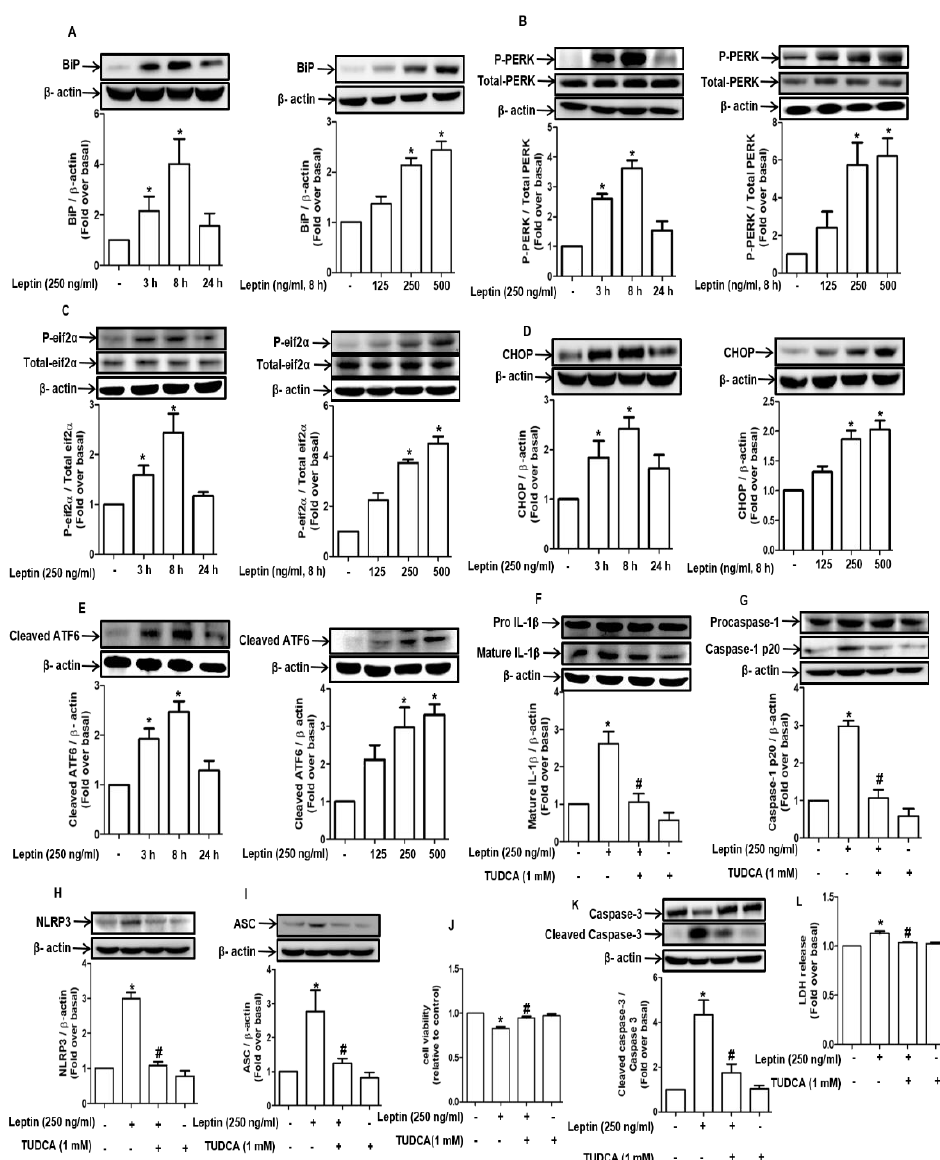
Figure 3. Involvement of ER stress in inflammasome activation by leptin in rat hepatocytes: ( A – E ) Rat hepatocytes were treated with leptin (250 ng/mL) for the indicated time duration or with different concentrations of leptin for 8 h. Dose- and time-dependent effects of leptin on the expression of various UPR proteins, including BiP ( A ), phospho PERK ( B ), phospho eif2 α ( C ), CHOP ( D ), and cleaved ATF6 ( E ) were assessed by Western blot analysis. ( F – L ) Hepatocytes were pretreated with TUDCA (1 mM) for 1 h followed by further stimulation with leptin (250 ng/mL) for 8 h. Expression levels of IL- 1β ( F ), caspase-1 ( G ), NLRP3 ( H ), and ASC ( I ) were measured by Western blot analysis. ( J ) Cell viability was determined by MTS assay. ( K ) Total and cleaved caspase-3 levels were measured by Western blot analysis. ( L ) The amount of LDH that was secreted was assessed. For Western blot analyses, expression levels of the genes were quantitated by densitometric analysis and were presented in the lower panel of each image. Values are presented as fold changes compared to the control group and are expressed as mean ± SEM, n = 3. In all of the experiments, * denotes p < 0.05 compared to the control cells; # denotes p < 0.05 compared with the cells treated with leptin alone.